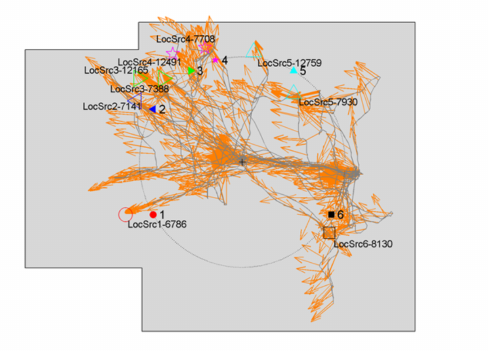
Figure 1. Virtual reality scenario with six sound sources constructed for the mental representation study [64].